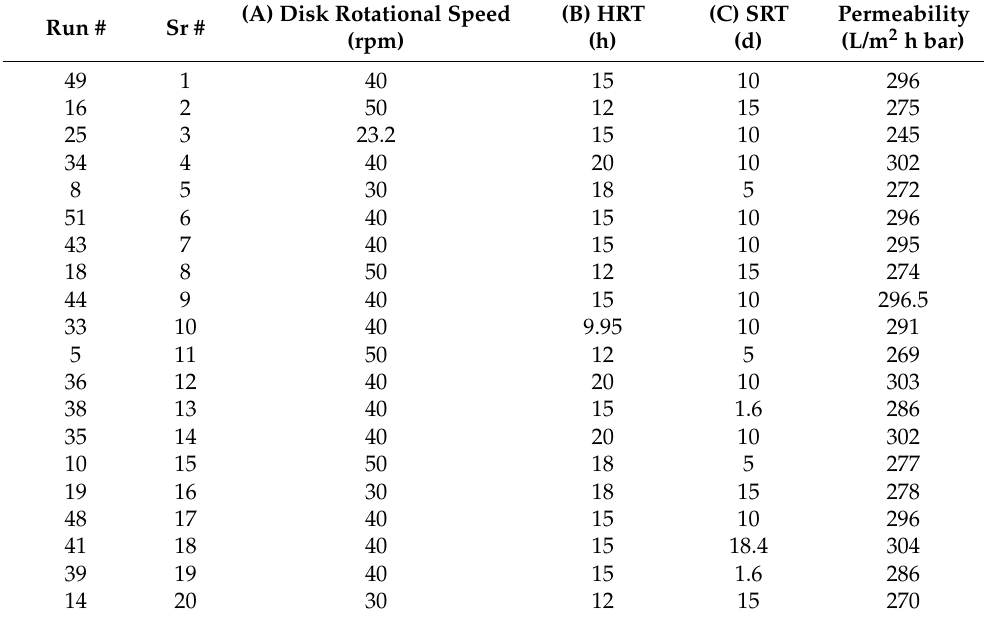
Table 2. Experimental Data for the Model Development.